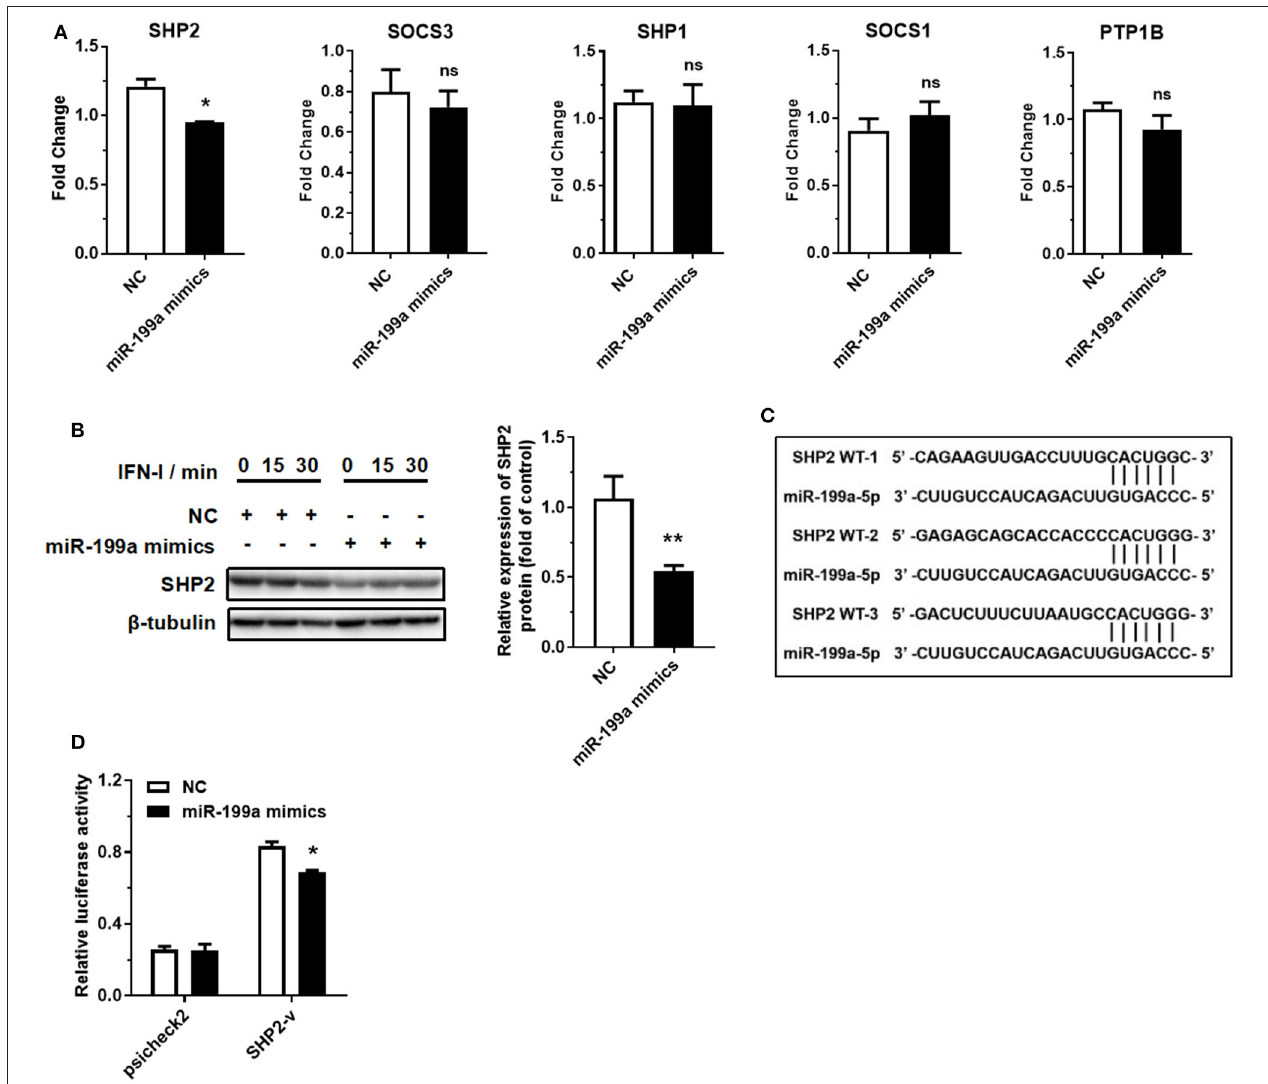
FIGURE 4 | miR-199a-5p promotes IFN-I-induced inflammation by targeting SHP2. (A) RT-qPCR analyses of five predicted miR-199a-5p target genes after treatment with miR-199a-5p mimics. (B) SHP2 protein assessment at 0, 15, and 30min of IFN-I stimulation after treatment with miR-199a-5p mimics. (C) Three miR-199a-5p binding sites within SHP2 3 ′ UTR predicted using the starBase database. (D) Luciferase activities of 293T cells co-transfected with blank psicheck2 vector or psicheck2 recombinant vector containing SHP2 3 ′ UTR fragment and miR-199a-5p mimics or NC. NC, negative control. SHP2-v, psicheck2 recombinant vector containing SHP2 3 ′ UTR fragment. Data represent means ± SEM. * p < 0.05, ** p < 0.01. ns, not